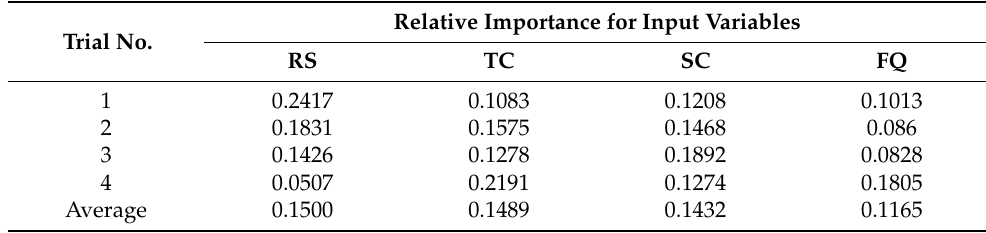
Table 7. Sensitivity Analyses of the Relative Importance of Artificial Neural Network Input Variables. Trial